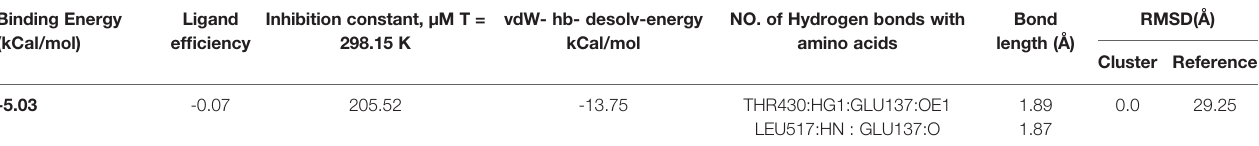
TABLE 1 | Summary of molecular docking score results of spike RBD with domain 2 of sFlt-1 obtained by Auto dock 4. Binding Energy (kCal/mol)